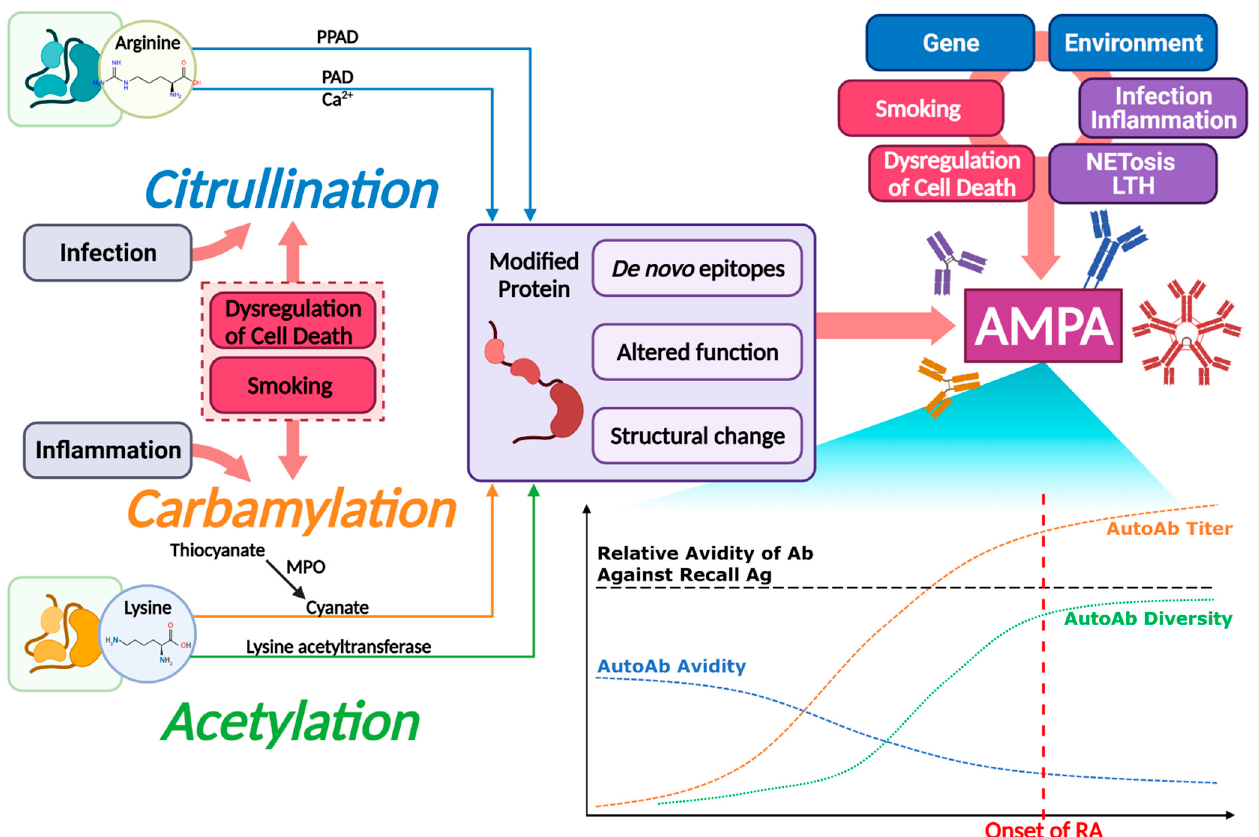
Figure 2. Schematic illustration of roles of posttranslational modifications (PTMs) and anti-modified protein antibodies (AMPAs) in rheumatoid arthritis (RA) pathogenesis. Citrullination, carbamylation, and acetylation self-modify proteins to generate autoantigenicity. Autoantigens induce the production of AMPAs. In pre-clinical stage of RA, the production of AMPAs is accompanied by the remodeling of antibodies. Simultaneously, AMPAs interact with other pathogenic factors of RA and undergoes isotype switching. Remodeling of autoantibodies lower the avidity of AMPAs, paradoxically heightening autoimmunogenicity. Titer and diversity of AMPAs gradually increase, driving the development of RA. All values in the graph are qualitative. Abbreviations: PAD, peptidylarginine deiminase; PPAD, PAD of Porphyromonas gingivalis ; MPO, myeloperoxidase; LTH, leukotoxic hypercitrullination; Ab, antibody; Ag, antigen; AutoAb, autoantibody. Created with Biorender.com.